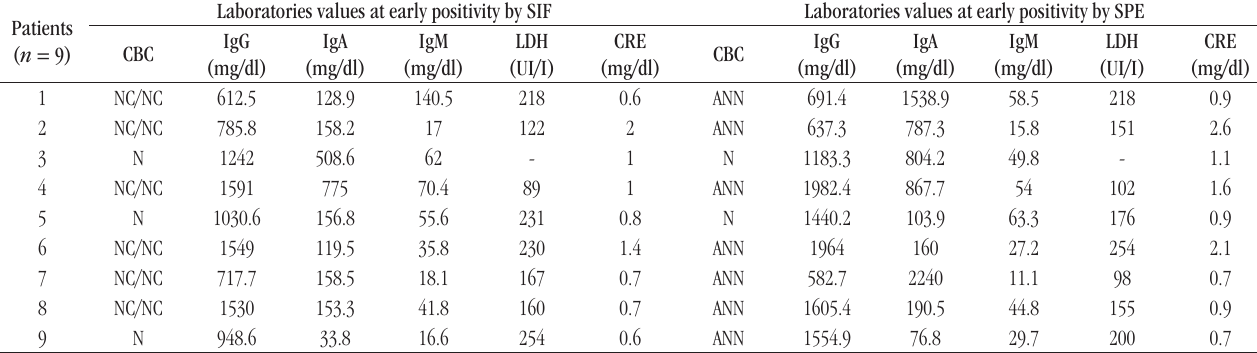
taBLE 4 − Laboratories parameters at early positivity by serum immunofixation (SIF) and at early positivity by serum electrophoresis (SPE) of relapsed patients Laboratories values at early positivity by SIF Laboratories values at early positivity by Patients